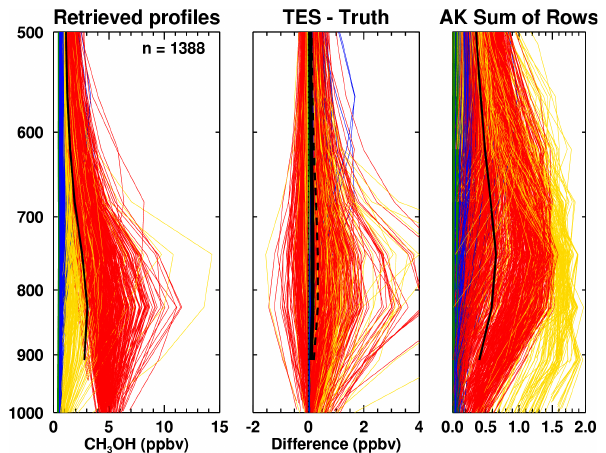
Fig. 7. Simulated methanol retrievals over North America in July 2008. Colored curves indicate the a priori selection (green: clean marine, blue: enhanced marine, yellow: clean continental, red: en- hanced continental). Left panel: retrieved profiles, with the mean re- trieved profile in black. Middle panel: retrieved minus true profiles. The solid line shows the mean bias, while the dashed line shows the standard deviation of the bias. Right panel: sum of the averag- ing kernel rows (SRAK) for each profile, with the mean in black. Means and standard deviations are not calculated for the surface level, since the height of this levels ranges from above 1000 to less than 800hPa.